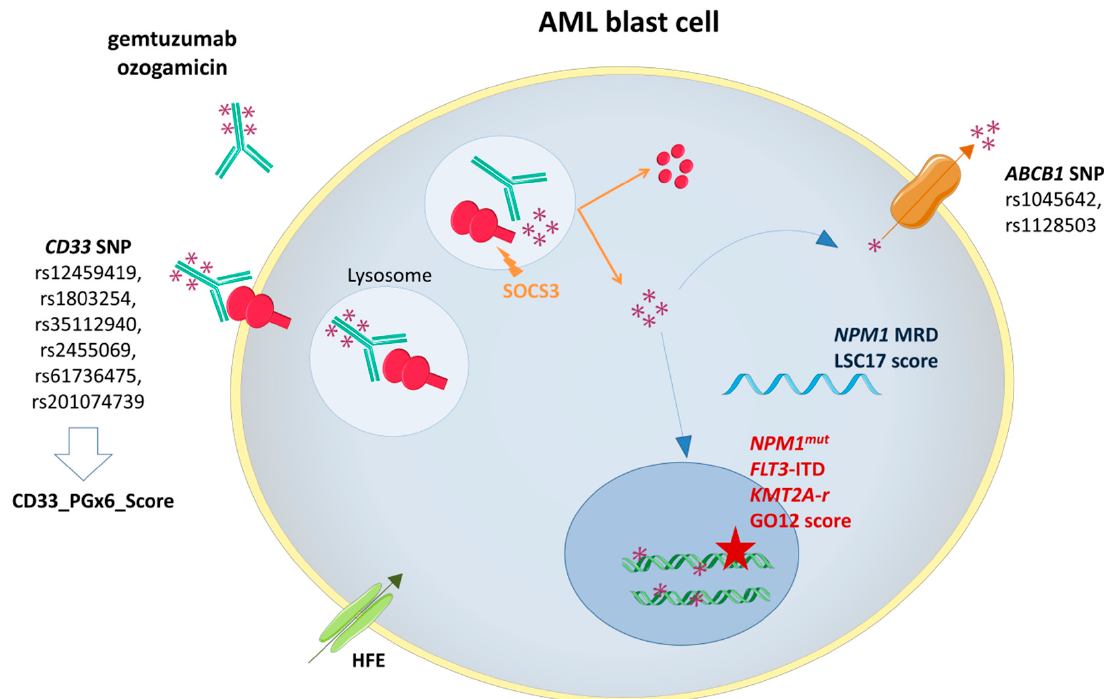
Figure 1. Gemtuzumab ozogamicin (GO) mechanism of action and biomarkers of response. SOCS3: Suppressor Of Cytokine Signaling 3; ABCB1 : ATP-binding cassette subfamily B member 1 gene; NPM1 mut : Nucleophosmin 1 gene mutation; FLT3 -ITD: FMS-Like Tyrosine Kinase 3 Internal Tandem Duplication; KMT2A -r: Lysine Methyltransferase 2A rearrangement.